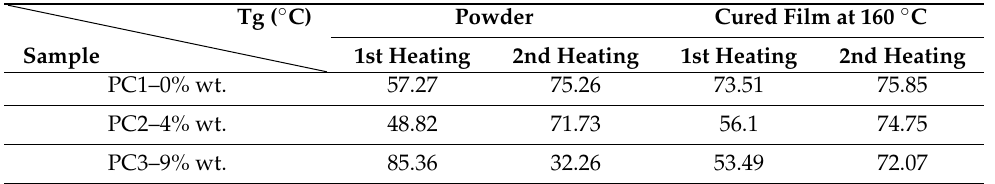
Table 2. Glass transition temperature (T g ) for each sample from DSC measurements for cycles of heating from 0 to 250 °C. Powder Cured Film at 160 °C T g (°C) Sample 1st Heating 2nd Heating PC1–0% wt.